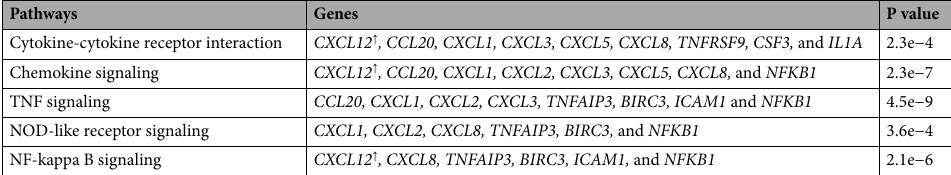
Table 2. In silico enrichment analysis of 26 DEGs of CCs from patients with endometriosis I/II. The in silico enrichment analysis was performed using the DAVID-Bioinformatics Resources 6.8 tool and KEGG database. ↑ = Positively regulated. All other genes were negatively regulated. P value <